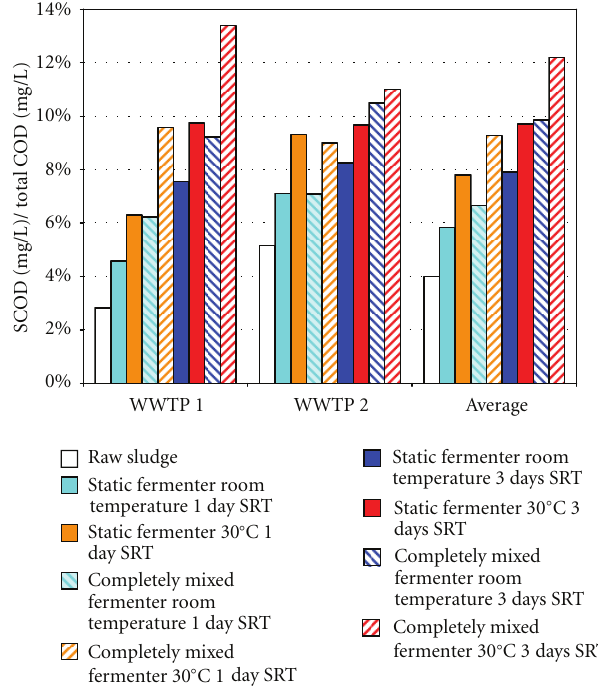
Figure 2: SCOD yield for WWTP 1, WWTP 2, and SCOD yield total